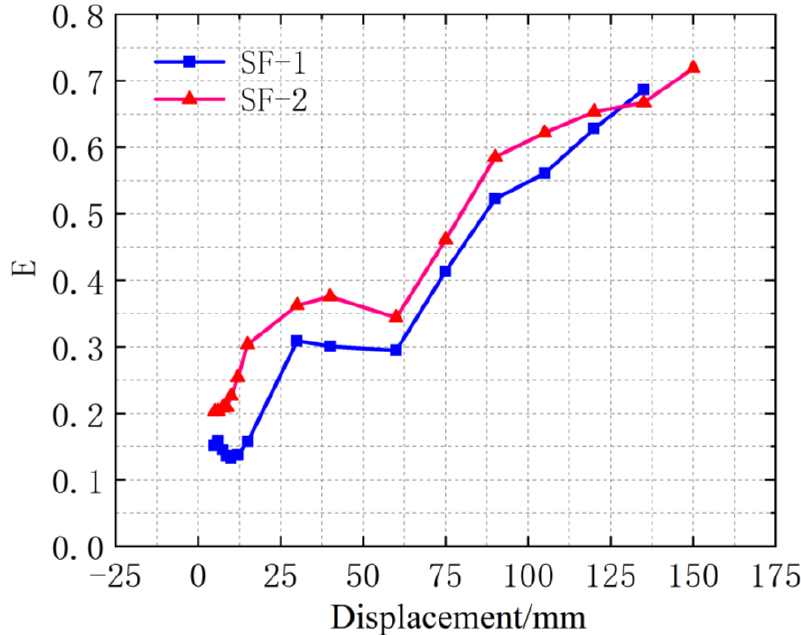
Figure 20. Energy dissipation coefficients of specimens SF-1 and SF-2.